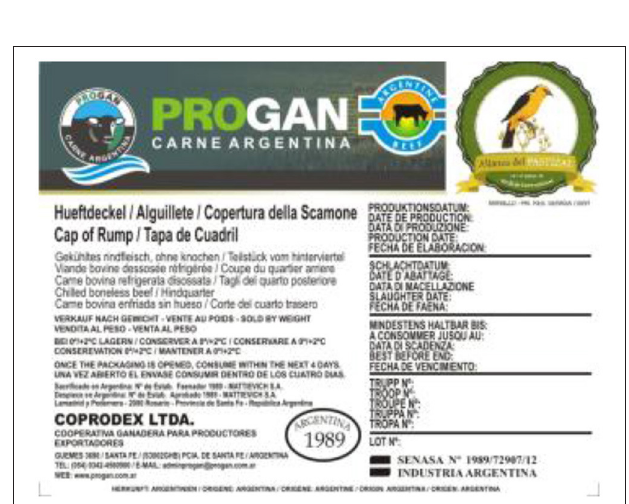
FIGURE 6 | Commercial label of beef exported by a cooperative of livestock farmers in Argentina certified for birdlife-friendly grazing management practises by the Native Grasslands Alliance ( Alianza del Pastizal ). https://www.birdlife.